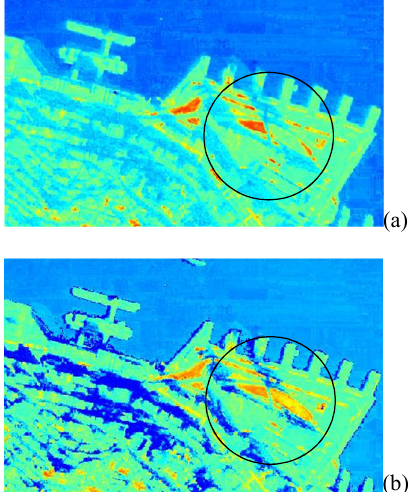
Figure 11. NDVI of Central - a) Original image; b) By Linear-Correlation Correction When comparing the black circle between Figure 12a, 12b and 12c, Gamma Correction did not show any significant improvement in detecting vegetation. NDVI by Linear-Correlation Correction is able to detect it as vegetation, but the value is much higher than its surrounding. To minimize this effect, the rescale process in both red band and infrared band have to be redesigned.